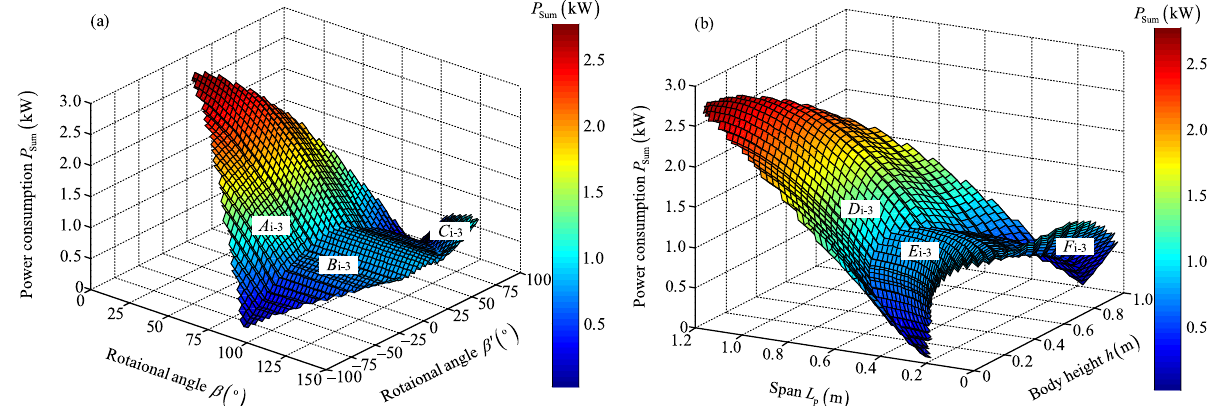
Figure 10 Variable tendency charts of P sum under secondary working conditions i-3: (a) With changes in β ′ and β , (b) with changes in h and L